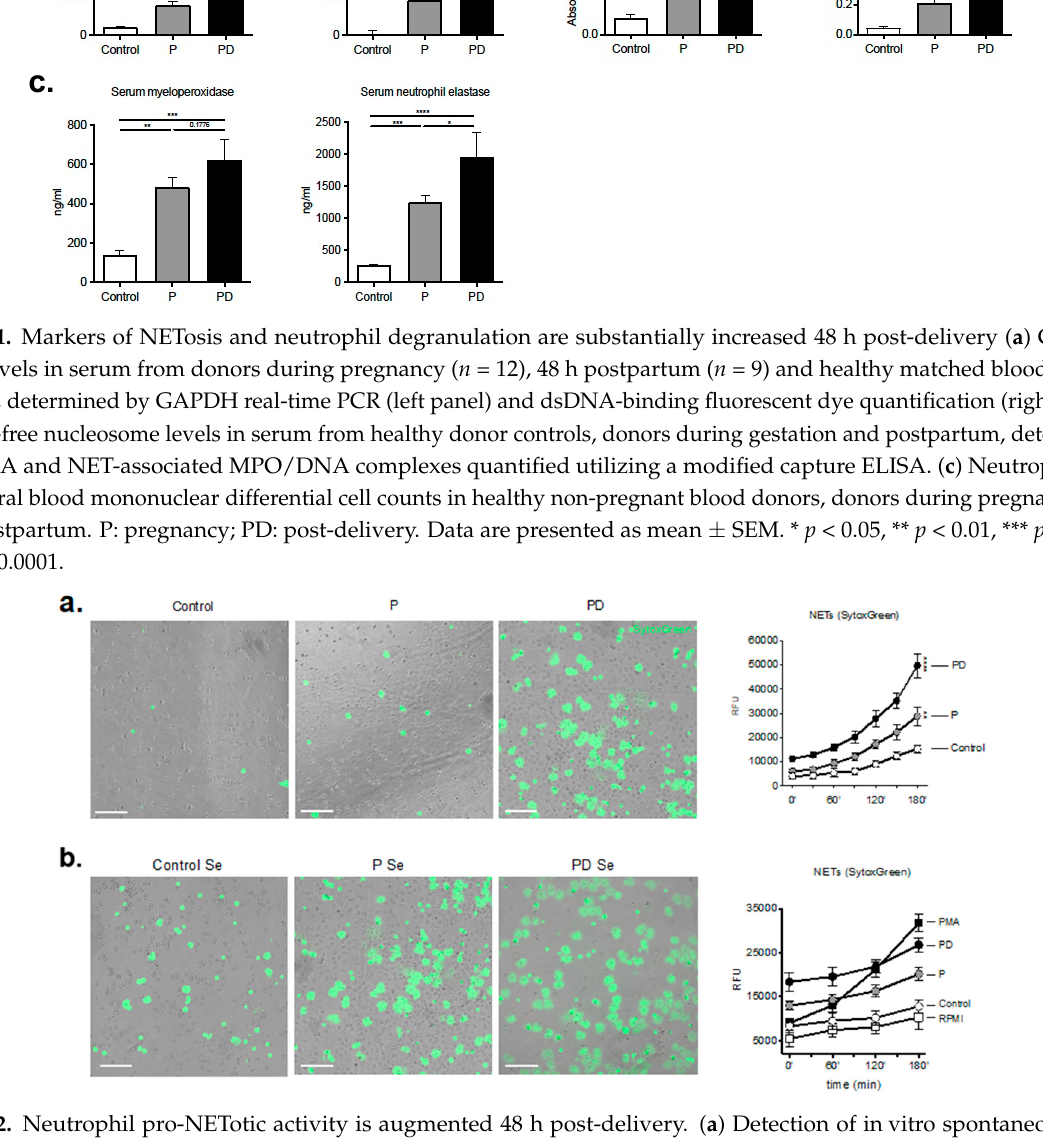
Figure 2. Neutrophil pro-NETotic activity is augmented 48 h post-delivery. ( a ) Detection of in vitro spontaneous NET formation of neutrophils from healthy controls, donors during pregnancy and postpartum release in a 3 h time course by fluorescence microscopy using dsDNA-binding fluorescent SytoxGreen dye and fluorimetry (right panel). ( b ) In vitro spontaneous extracellular DNA release monitored in a 3 h time course by SytoxGreen dye microscopy after treatment of